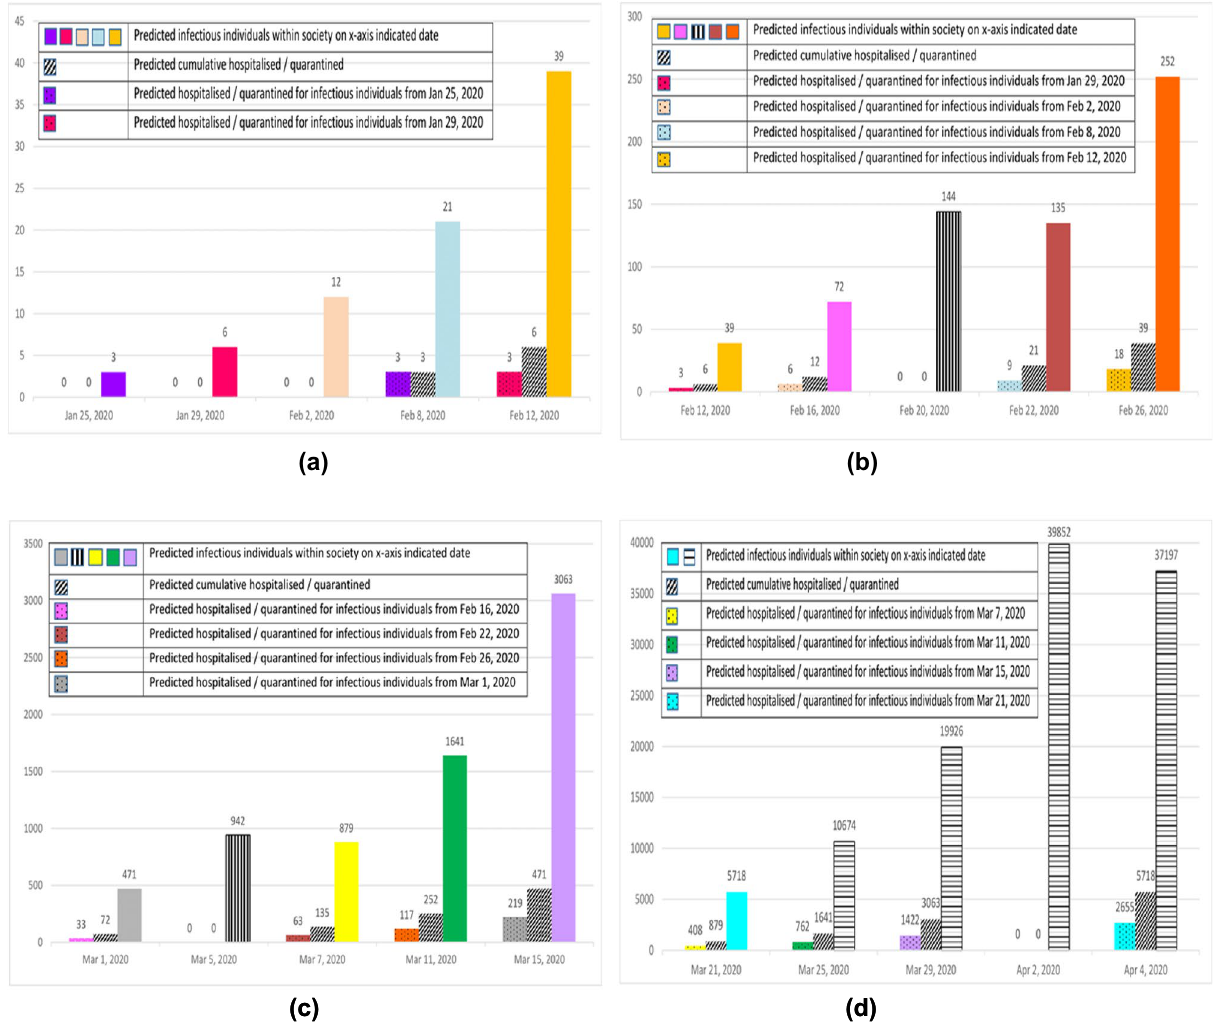
Figure 3. Predicted Cumulative according to 14-day period. ( a ) Jan 25, 2020 and Feb 12, 2020. ( b ) Feb 12, 2020 and Feb 26, 2020. ( c ) March 1, 2020 and March 15, 2020. ( d ) March 21, 2020 and April 4, 2020. The colour codes in Fig. 3a–d were used to identify the 14-day period of each infectious cohort beginning from the first day the cohort becomes infectious. For example, in Fig. 3a the colour purple-blue for the first cohort of infectious individuals on Jan 25, 2020: it is predicted that there are three infectious individuals within the society, where three of them will show symptoms and be hospitalised after a 14-day period on Feb 8,